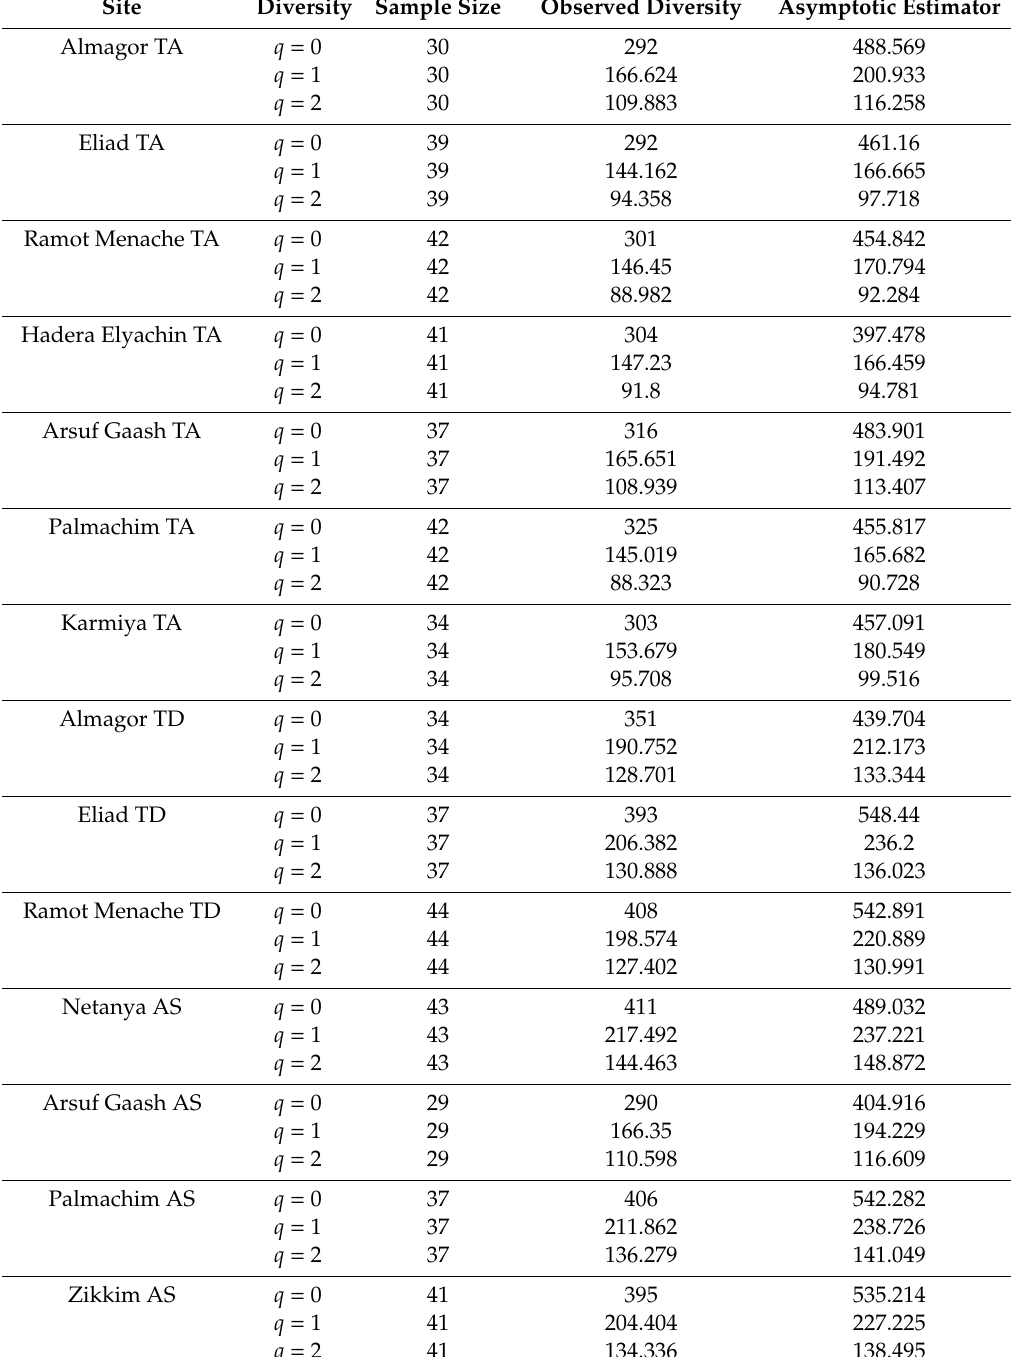
Table 2. Incidence-based interpolation and extrapolation curves indicating diversity in terms of the Hill numbers of order q : species richness ( q = 0), exponential of Shannon entropy ( q = 1) and inverse of Simpson concentration ( q = 2),